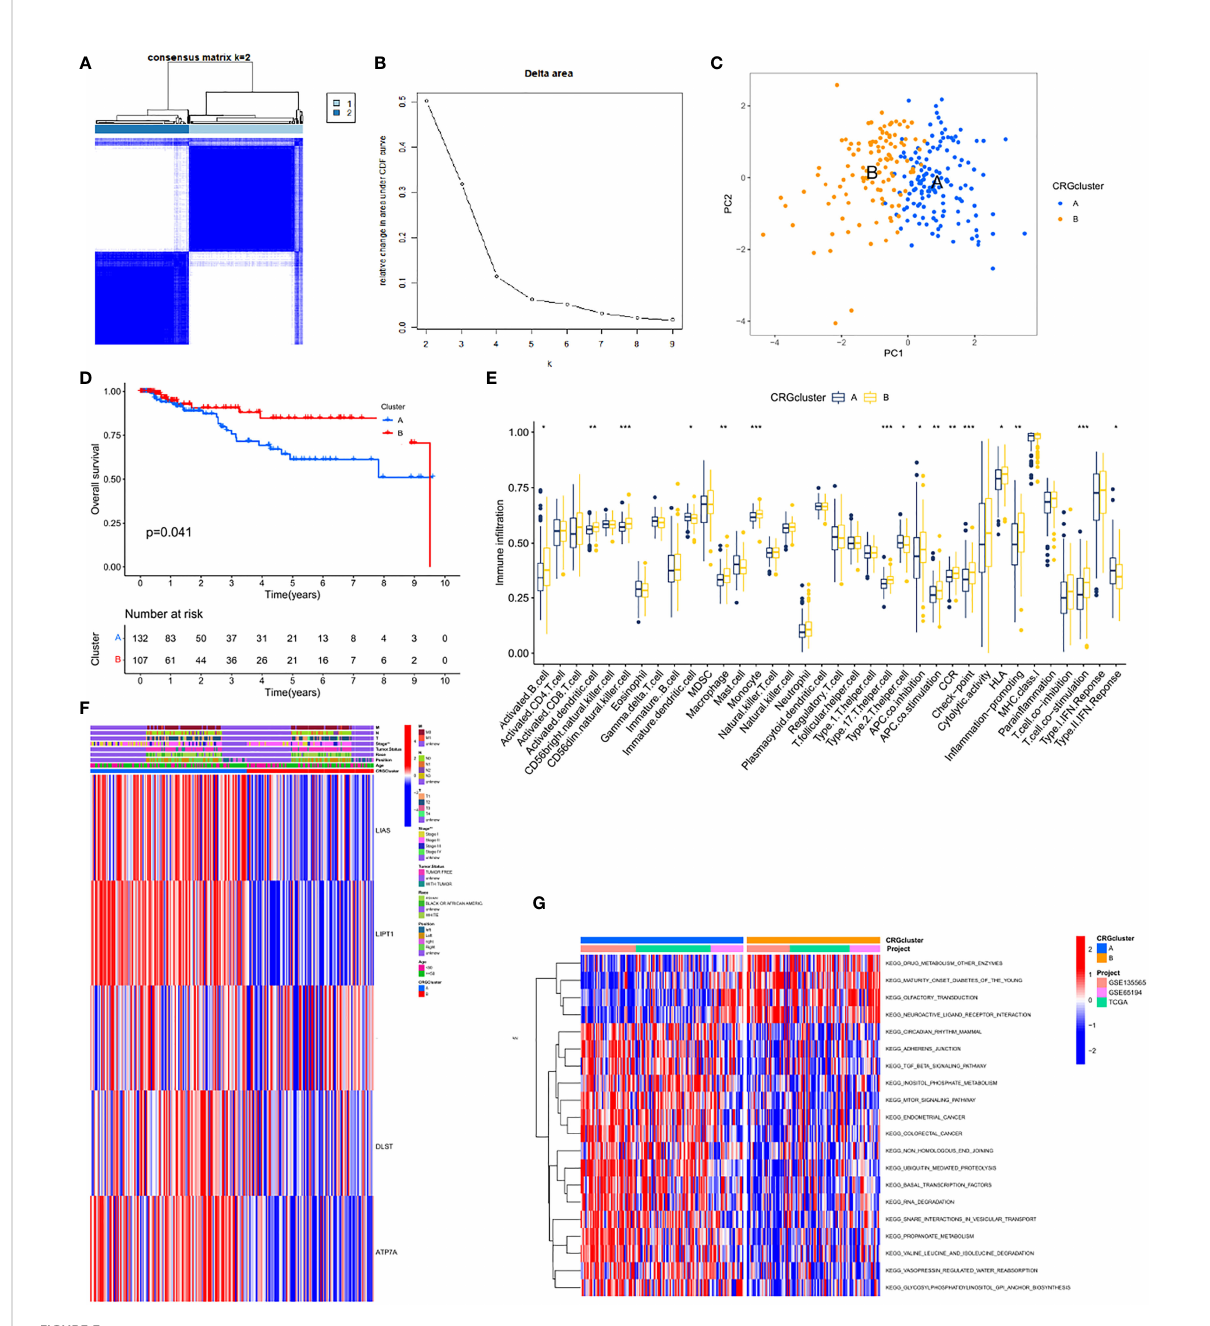
FIGURE 3 CRG subtypes and clinicopathological and biological characteristics of two distinct subtypes of samples divided by consistent clustering. (A) Consensus matrix heatmap de fi ning two clusters (k = 2) and their correlation area. (B) relative change area under cumulative distribution function curve. (C) PCA analysis revealed signi fi cant differences in transcriptome between the two subtypes. (D) Kaplan-Meier curve showed that there were signi fi cant survival differences between cluster A and B (P=0.041). (E) The abundance of each TME in fi ltrating cell in two clusters. The upper and lower ends of the boxes represented interquartile range of values. The lines in the boxes represented median value, and black dots showed outliers. The asterisks represented the statistical p value (*P < 0.05; **P < 0.01; ***P < 0.001). (F) Differences in clinicopathologic features and expression levels of CRGs between the two distinct subtypes. (G) GSVA of biological pathways between two distinct subtypes, in which red and blue represent activated and inhibited pathways,